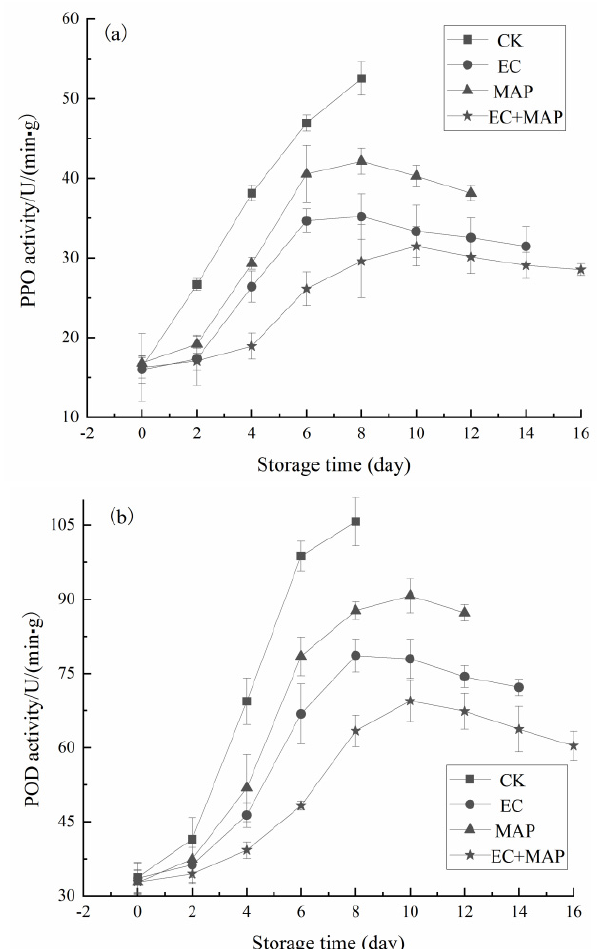
Figure 5. Effect of different treatments on PPO activity ( a ) and POD activity ( b ) of fresh-cut pineapples during storage.